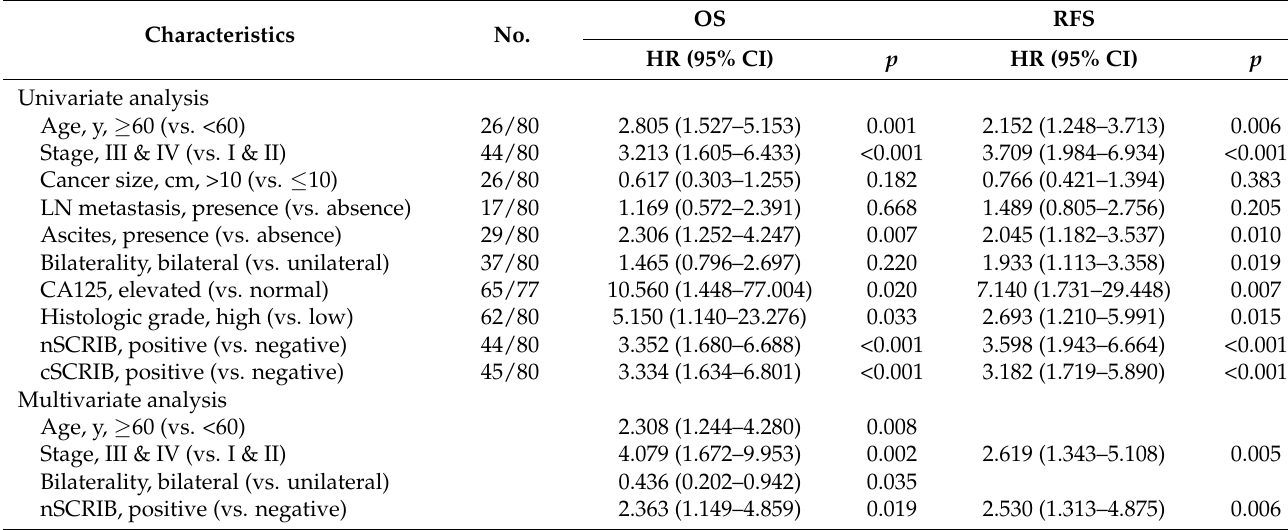
Table 4. Multivariate Cox regression analysis in overall ovarian carcinoma and 62 high-grade ovarian carcinomas. Characteristics